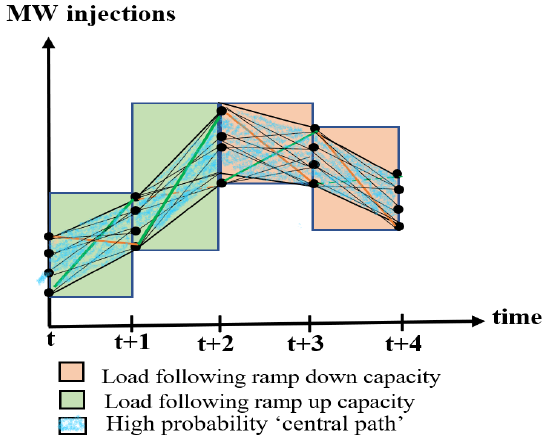
Figure 5. Load-following ramping reserves and ramping in the normal state